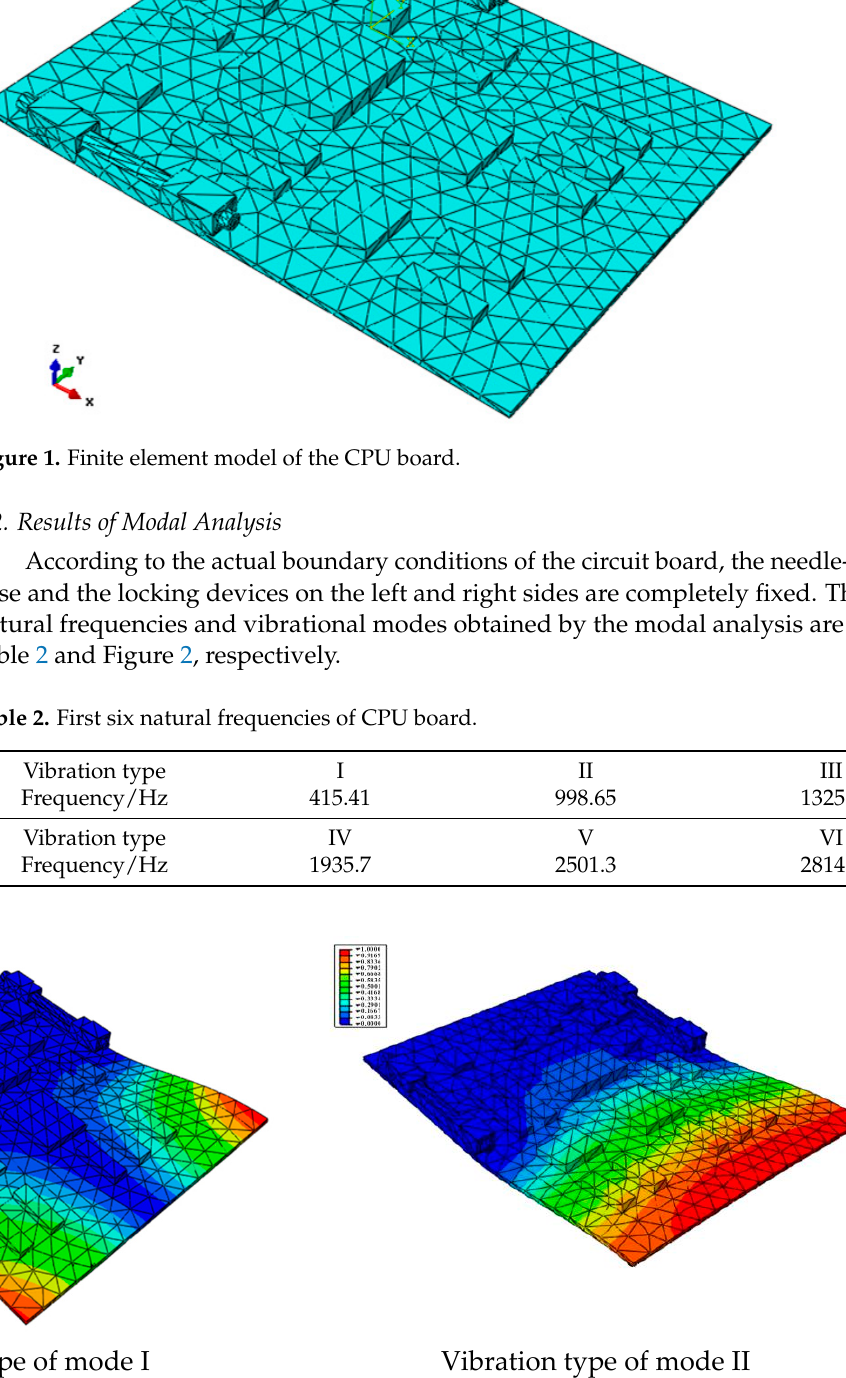
Figure 1. Finite element model of the CPU board. Table 1. Material parameters of the CPU board model.